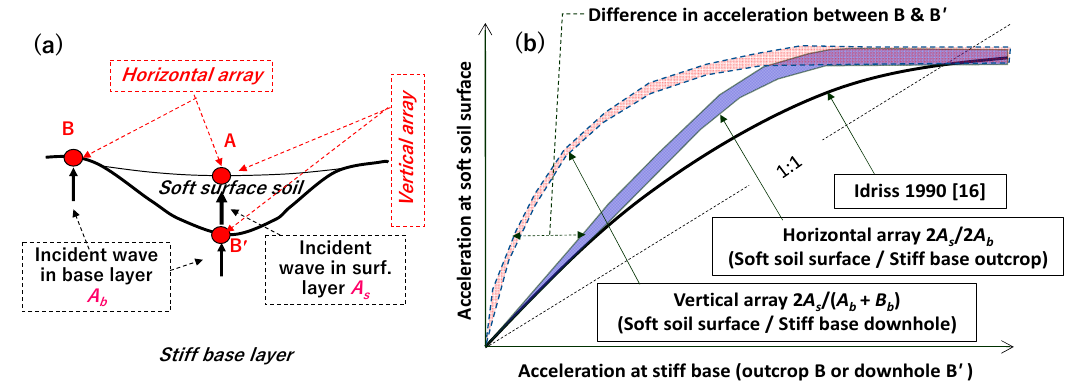
Figure 16. Horizontal array versus vertical array ( a ), and Schematic variations of soft soil surface acceleration versus stiff base acceleration compared between horizontal array 2 A s /2 A b and vertical array 2 A s /( A b + B b ) ( b ).